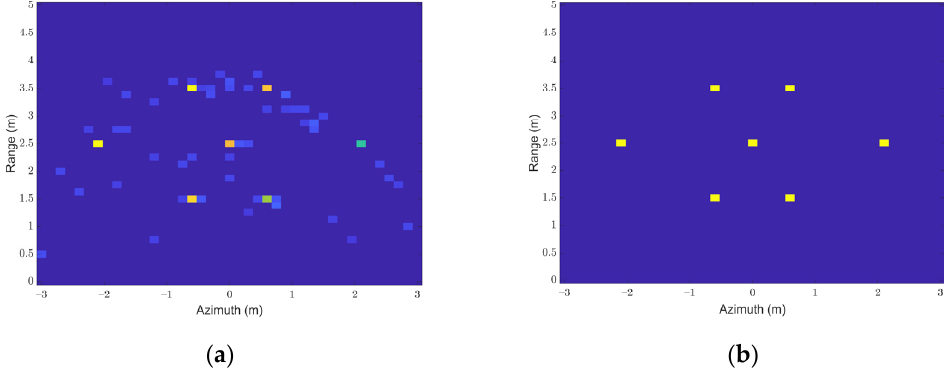
Figure 3. Imaging Results Contrast. ( a ) Results without compensation of errors; ( b ) Results of the proposed method.